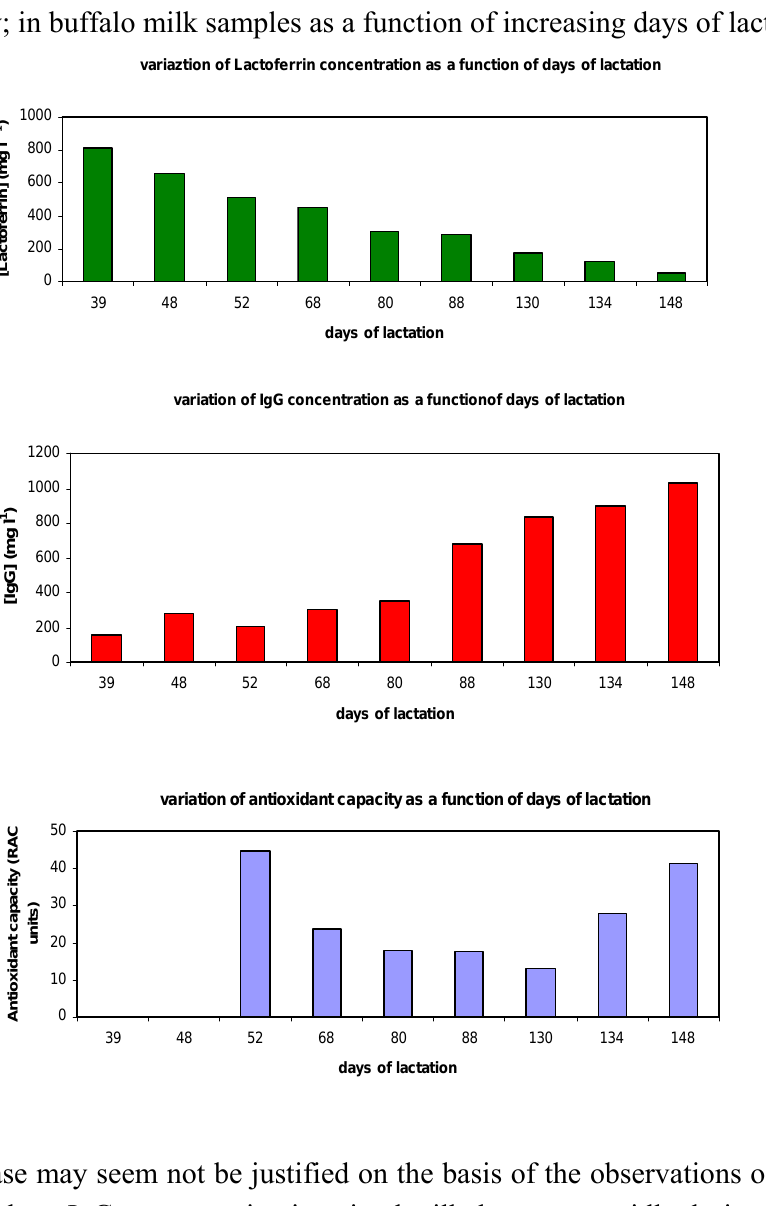
Figure 8. Trends in: (a) lactoferrin concentration; (b) IgG concentration; (c) Antioxidant capacity; in buffalo milk samples as a function of increasing days of